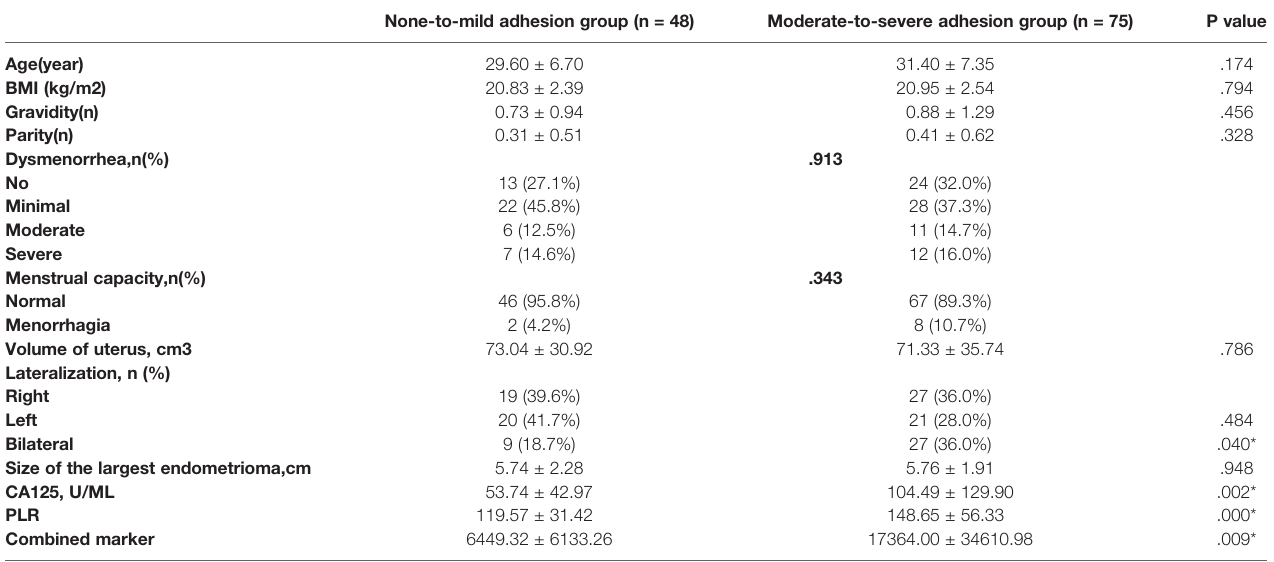
TABLE 3 | Comparison of characteristics between the none-to-mild adhesion group and moderate-to-severe adhesion group. None-to-mild adhesion group (n = 48)